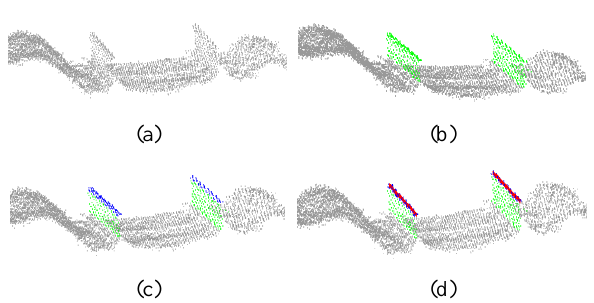
Figure 5. (a) Main track region, (b) track candidate points (green color), (c) rail head point clustering (blue color), and (d) 3D track model reconstruction (red color).